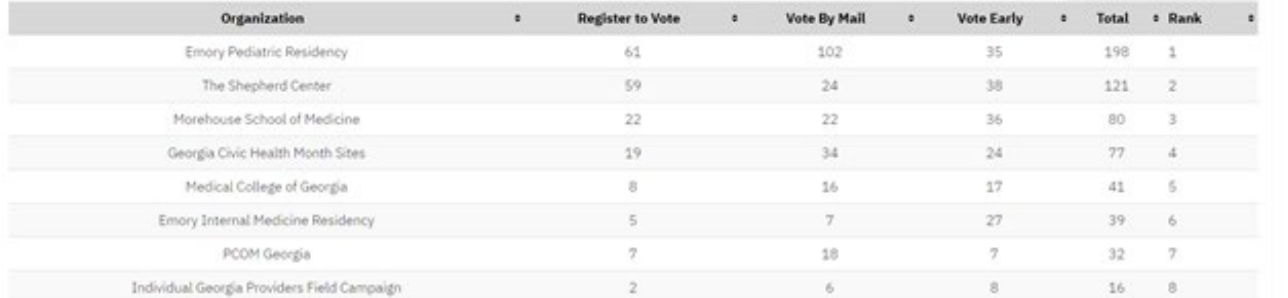
Table 1 Metrics for reporting